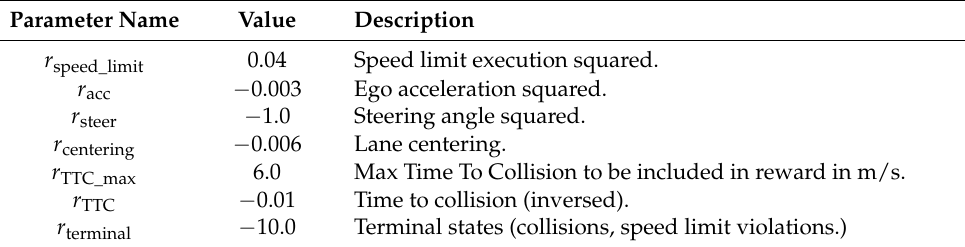
Table A3. Values of reward components weights for the direct control driving policy training.